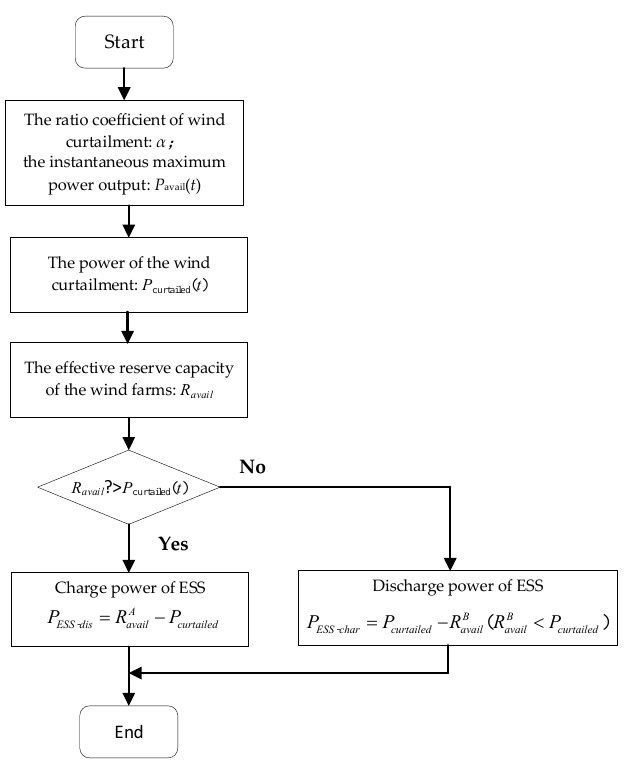
Figure 5. Flowchart of the mean value method.